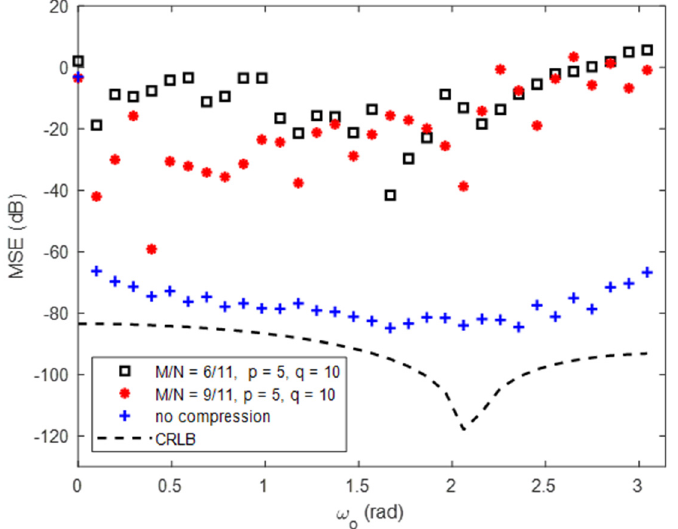
Figure 7. Frequency estimation mean square error versus 𝜔 𝑜 for the colored noise case. SNR = 30 dB, 𝛼 = 5 and B = 10, using CCS with different compression ratios as well as the estimator without compression [27], p = 5, q = 10.